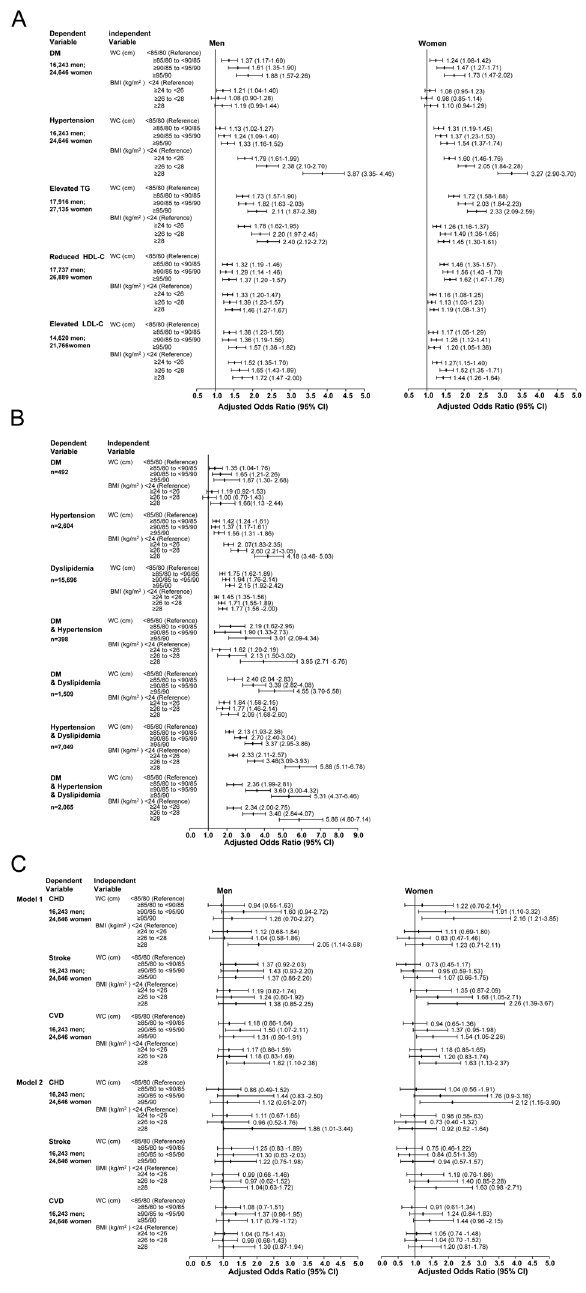
Figure 1. Associations of waist circumference/BMI categories with CMD and CVD. Binary or multinominal multivariable logistic regression was conducted to assess the association of separate WC and BMI categories with CMD (Figure 1A and Figure 1B) and CVD (Figure 1C) using the Entry method; adjusted odds ratios (ORs) and the 95% confidence intervals (CIs) are given. The dependent variables were CMD (DM, hypertension, elevated TG, reduced HDL-C, elevated LDL-C) and CVD (CHD, stroke, and CVD) in binary logistic regression, and the dependent variables were the category variable of different CMD combinations with the group without any CMD as the referent in multinominal logistic regression. The independent variables were mutually adjusted WC and BMI categories. Adjustment variables included the basic confounders (age, education levels, smoking status, drinking status, physical activity) and family history of diseases (identified as the dependent variables) in Figure 1A, Figure 1B, and Figure 1C ( Model 1 ) . In Figure 1C (Model 2), CMD